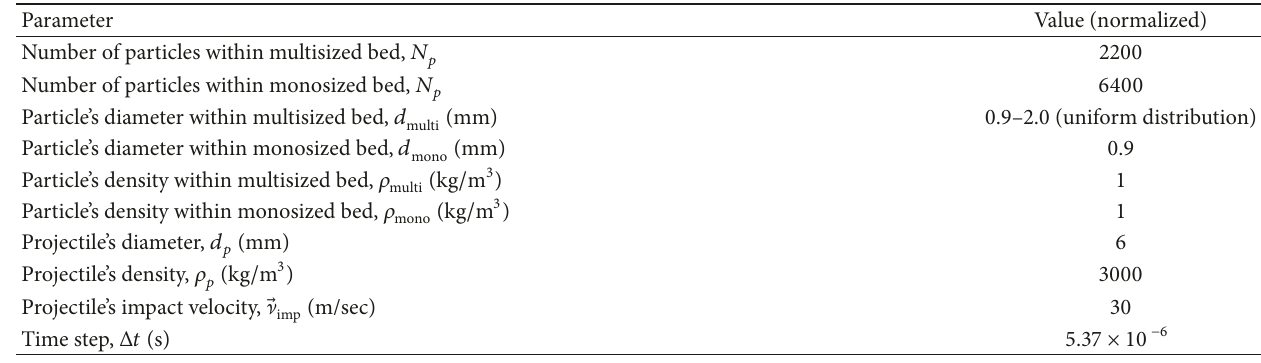
Table 1: Parameter values used in simulation.